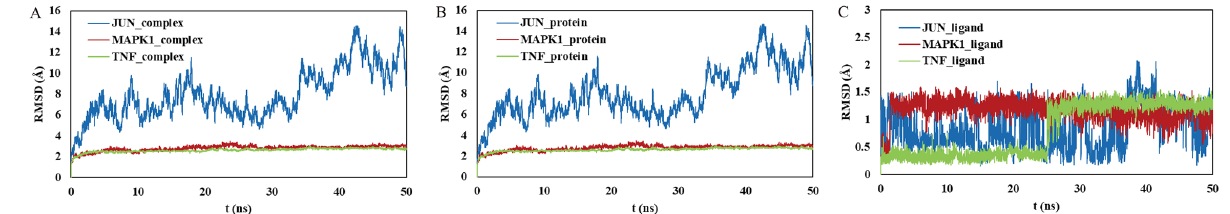
Figure 8. RMSD plot during molecular dynamics simulations. ( A ) The RMSD of protein–ligand complex during MD simulation. ( B ) The RMSD of protein during MD simulation. ( C ) The RMSD of quercetin during MD